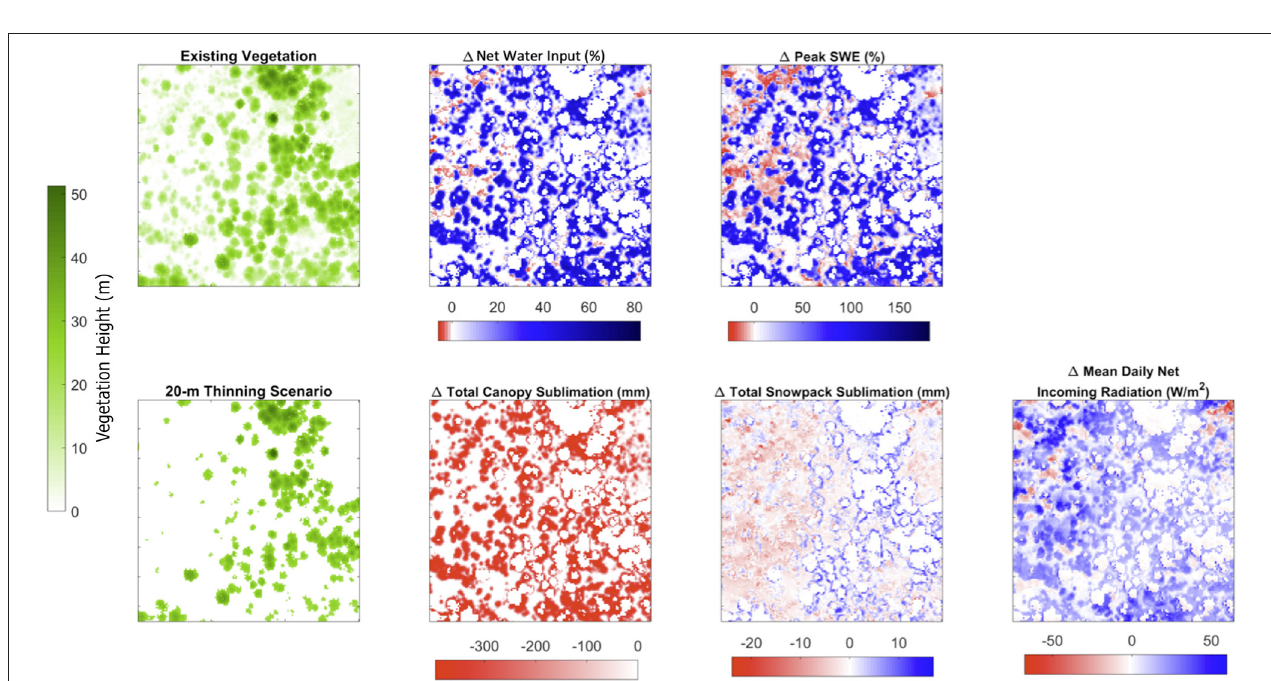
FIGURE 3 | Model validation of snow water equivalent (SWE) and snow depth for Ward #3 (Left) and Tahoe City Cross (Right) SNOTEL stations. Upper panels include the difference between simulated and observed mean daily air temperature, with positive values indicating a model overestimation.